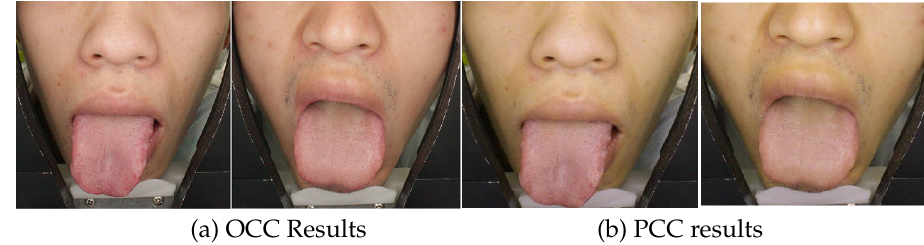
Figure 16. The PCC results with typical recommended user